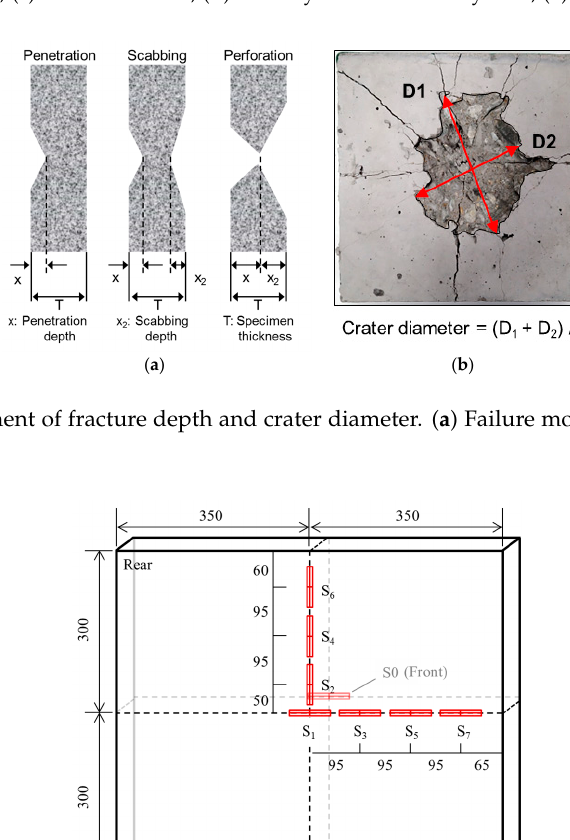
Figure 7. Position of strain gauges. (S0: Center of front face, S1~S7: Rear face, Sampling rate: 200,000 Hz).